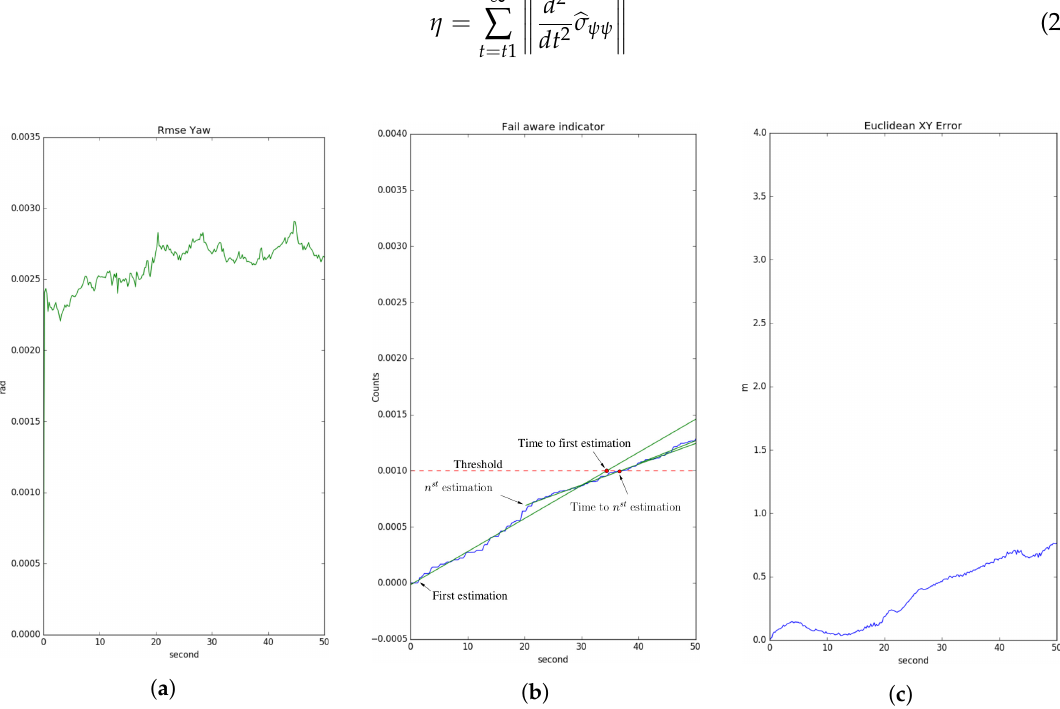
Figure 18. Fail-aware process. Sequence results 03. ( a ) Evolution of the signal standard deviation of estimated by the filter ( σ ψψ ). ( b ) Representation of the failure threshold (red) and fail-aware indicator η (blue). The green lines represent the equation to evaluate the time window to reach the failure threshold. ( c ) Euclidean [ x , y ] error compared with the ground truth (GT) of the data